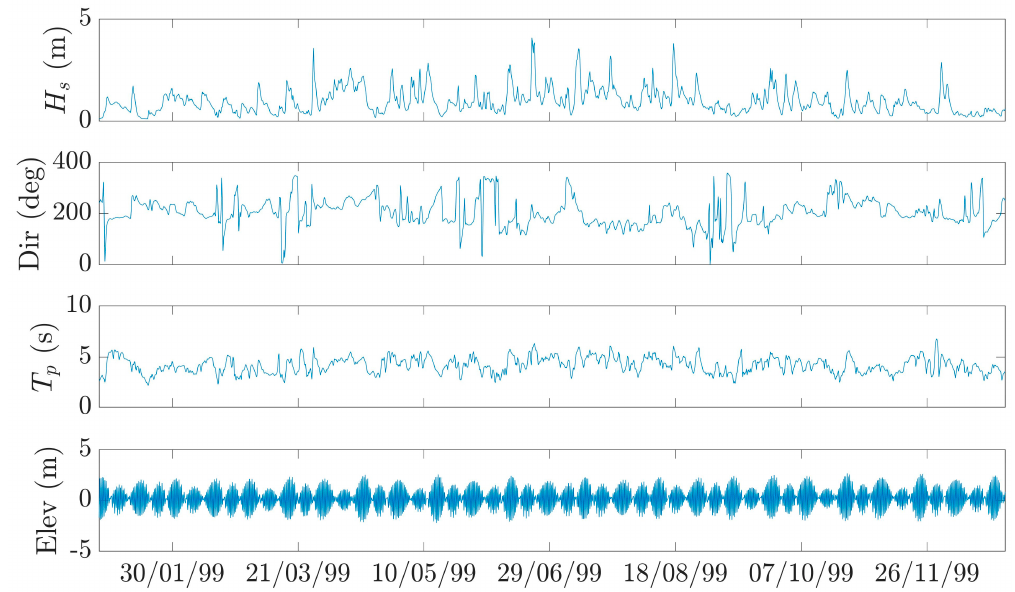
Figure 12. Offshore wave and tidal elevation time series used as boundary conditions. The wave data is from the UKCP09 downscaled data at a point located 2.5 km offshore and 20 m depth of the study site. The elevation data are from the Cromer tide gauge station and referred to m above Newlyn datum.